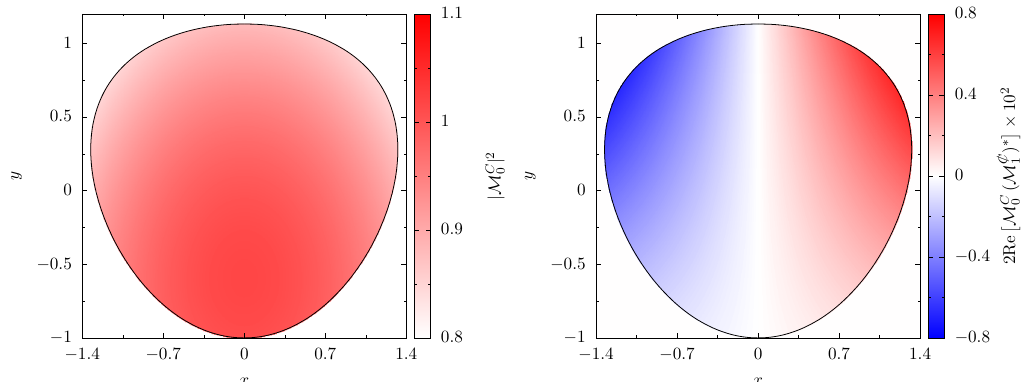
Figure 9 . Dalitz-plot decomposition for η 0 → ηπ + π − as given in eq. (3.33) for our central solution. The normalization is chosen such that the full amplitude |M| 2 is one in its center. The interference term of M C and M 6 C gives rise to the breaking of mirror symmetry. Note the relative order of 0 1 magnitudes between the individual